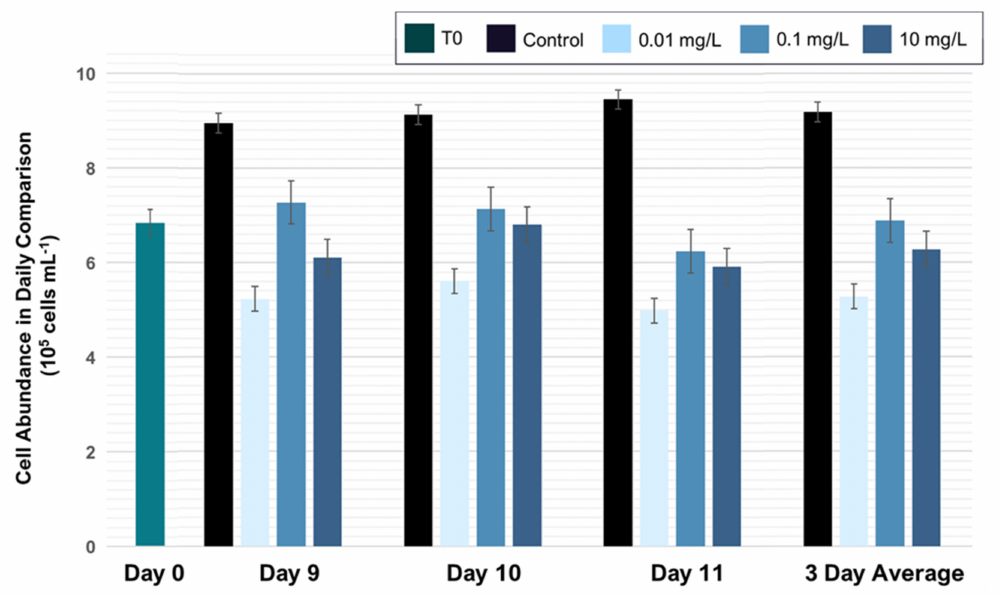
Figure 1. Treatment and control tanks were sampled after 9, 10, and 11 days. Experiments started with ~680,000 cells / mL in all tanks. There are differences between the growth rate in the different treatments, but the ratio stays the same over all three sampling days. The cell density in the control was 9.83 ± 0.39 × 10 5 cells per mL, while treatment tanks were significantly lower: 0.01 mg / mL: 5.69 ± 0.12 × 10 5 cellspermL,0.1mg / mL:7.51 ± 0.34 × 10 5 cellspermL,and10mg / mL:6.96 ± 0.40 × 10 5 cells per mL. Bars display a confidence